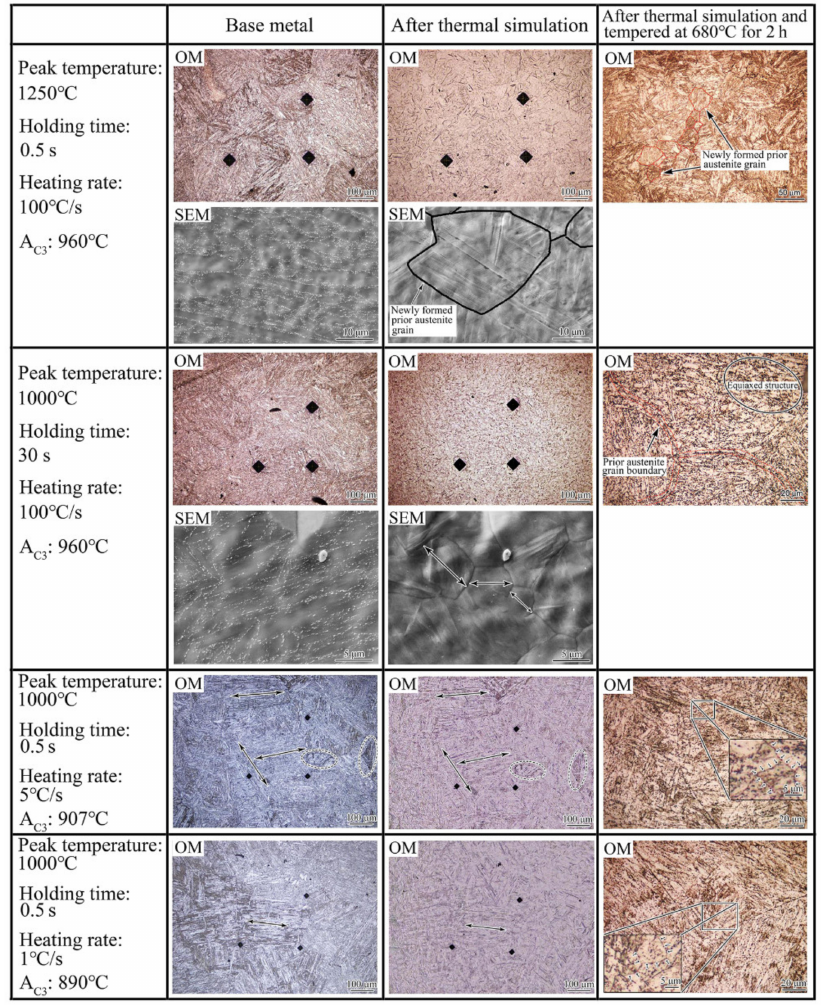
Figure 11. OM and SEM images of FB2 steel for the same location before and after the thermal simulation (not grinded, polished, and chemically etched again), and for a certain location after the thermal simulation and tempering at 680 ◦ C for 2 h (grinded, polished and chemically etched again)